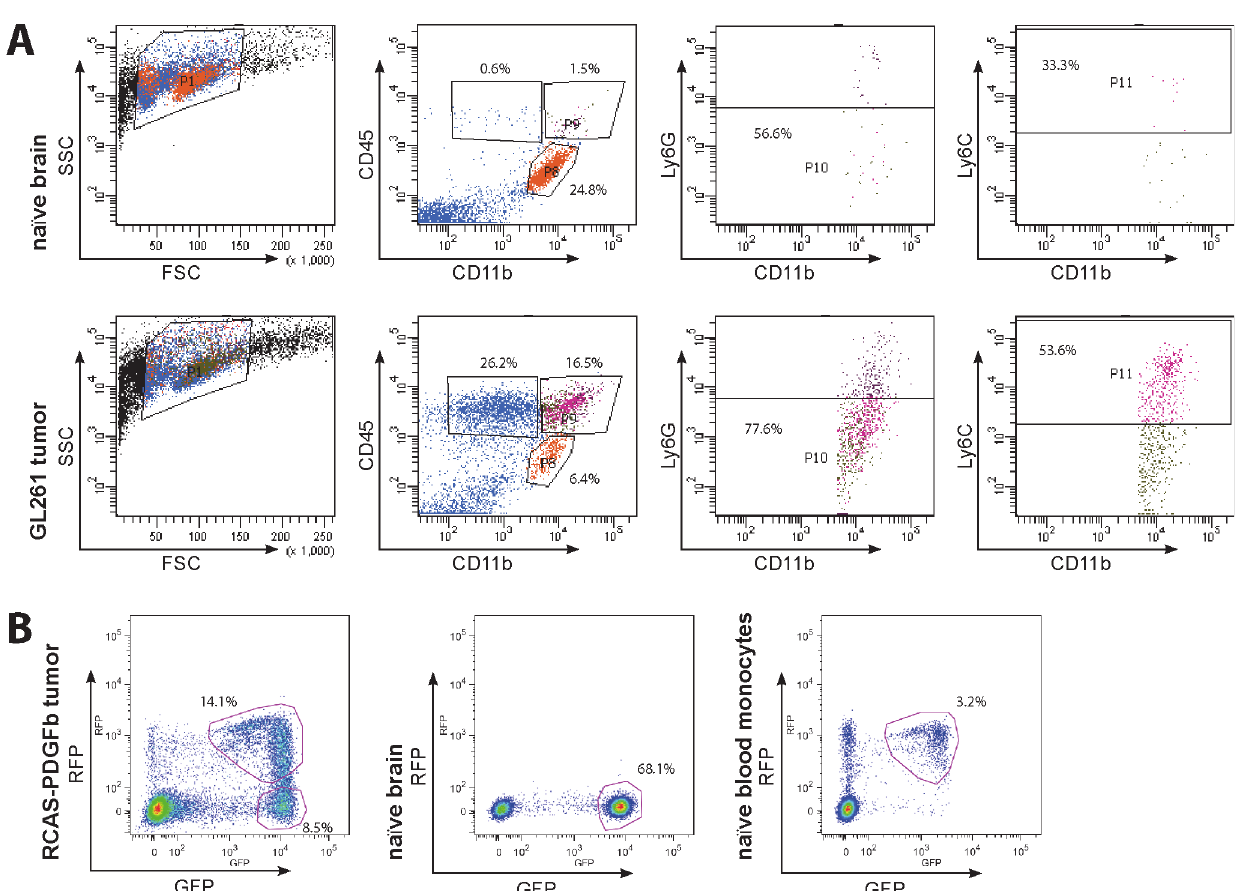
were not taken from healthy patients, but patients suffering from epilepsy (3 samples) and trauma injury (1 sample). In these conditions the microglia might have already been polarized toward an M2-like phenotype.